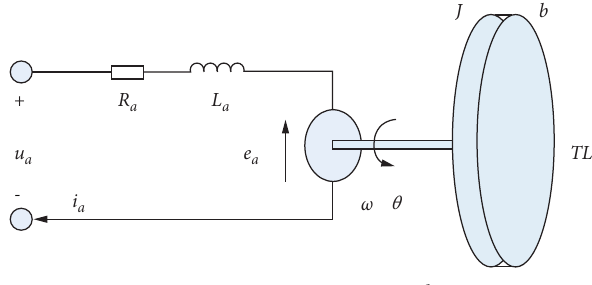
Figure 4: Motor circuit structure diagram.